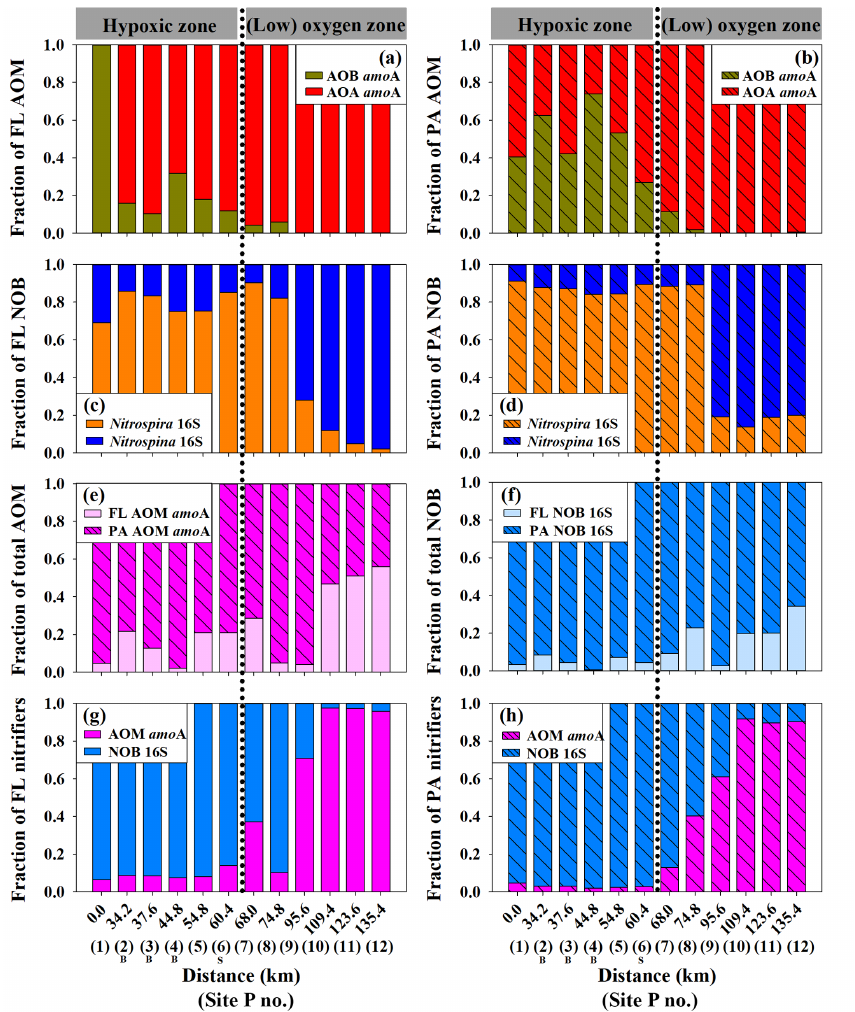
Figure 6. Gene abundance distribution of four nitrifier groups along the PRE transect. (a) Relative abundance of archaeal (AOA) and β - proteobacterial (AOB) amo A genes in total FL AOM (sum of archaea and β -proteobacteria) amo A genes. (b) Relative abundance of AOA and AOB amo A genes in total PA AOM amo A genes. (c) Relative abundance of Nitrospira and Nitrospina 16S rRNA genes in total FL NOB (sum of Nitrospira and Nitrospina ) 16S rRNA genes. (d) Relative abundance of Nitrospira and Nitrospina 16S rRNA genes in total PA NOB 16S rRNA genes. (e) Relative abundance of FL and PA AOM amo A genes in total amo A genes. (f) Relative abundance of FL and PA NOB 16S rRNA genes in total 16S rRNA genes. (g) Relative abundance of AOM amo A and NOB 16S rRNA genes in total FL nitrifier genes. (h) Relative abundance of AOM amo A and NOB 16S rRNA genes in total PA nitrifier genes. Depth-weighted abundances were used to calculate relative abundances for each site. B, only the bottom water was sampled; S, only the surface water was